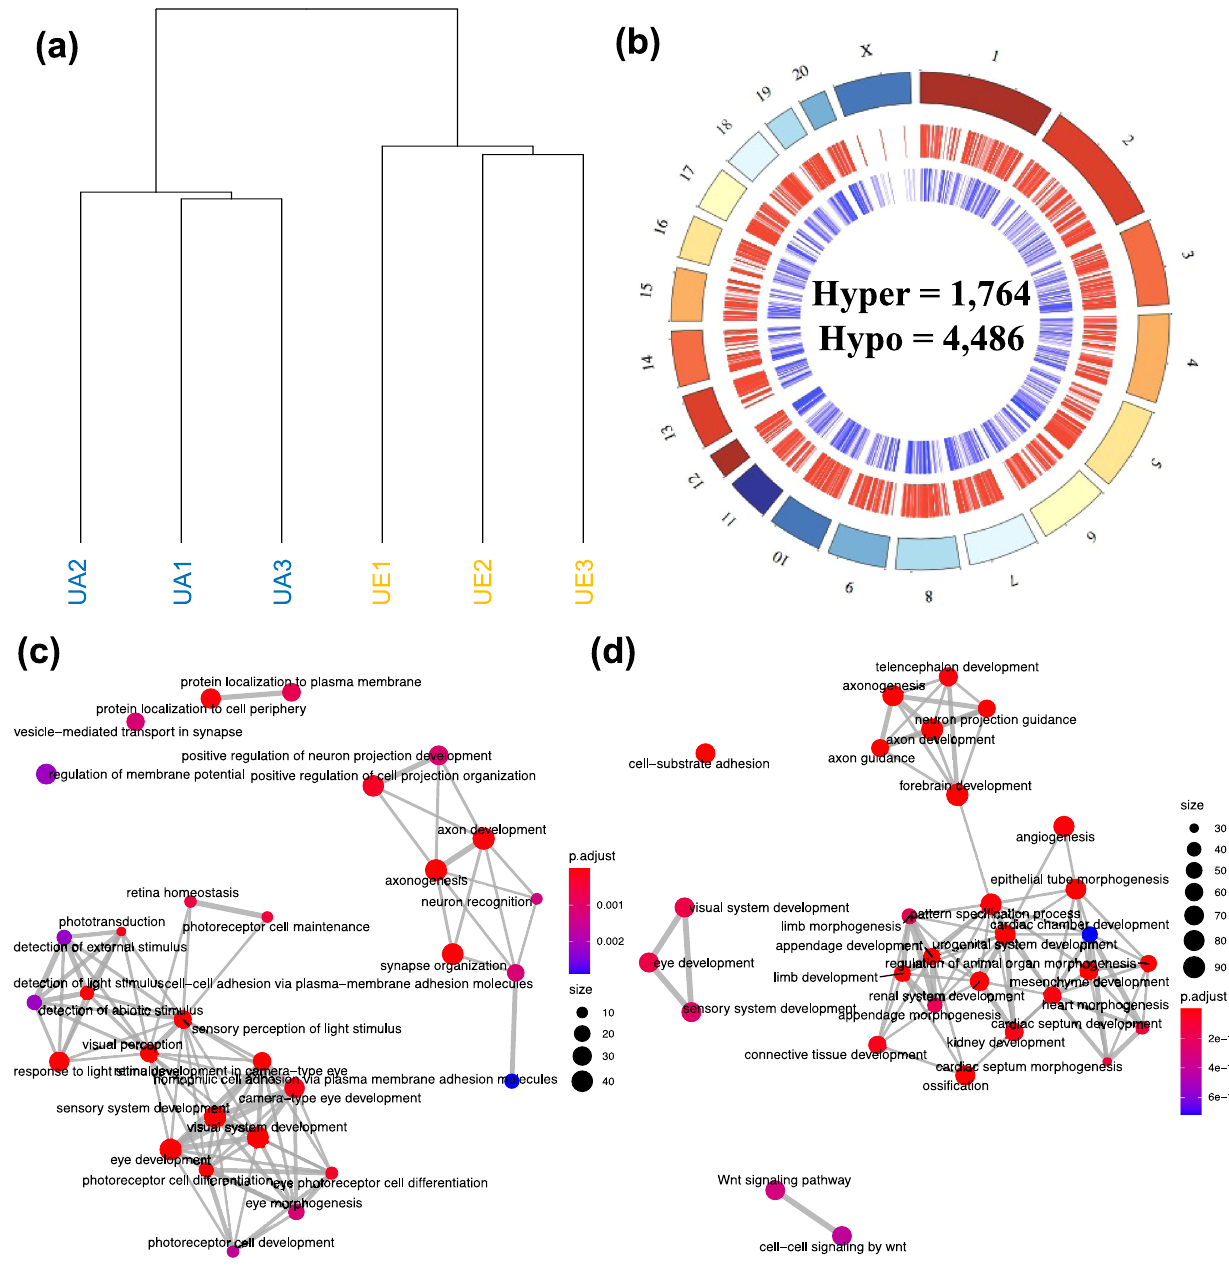
Fig. 5 Differential methylation levels distinguish embryonic (UE) from adult (UA) uninjured RGCs. a Unsupervised hierarchical clustering using global levels of DNA methylation distinguish uninjured adult (UA) (blue) ( N = 12 retinas) from uninjured embryonic (UE) (orange) ( N = 12 retinas) samples. b A circos plot depicts the genome-wide relative location of hypo DMRs ( N = 4486; red; middle circle) and hyper DMRs ( N = 1764; blue; inner circle) in association with the chromosomes (outer circle) across the genome. c , d Enrichment map plots show the interconnectivity of top ontological terms derived from hypermethylated and hypomethylated genes, respectively, that differentiate UA from UE samples. Color of dots represents the adjusted P value for each of the displayed ontological terms. Size of dots represents the relative number of genes associated with each displayed ontological